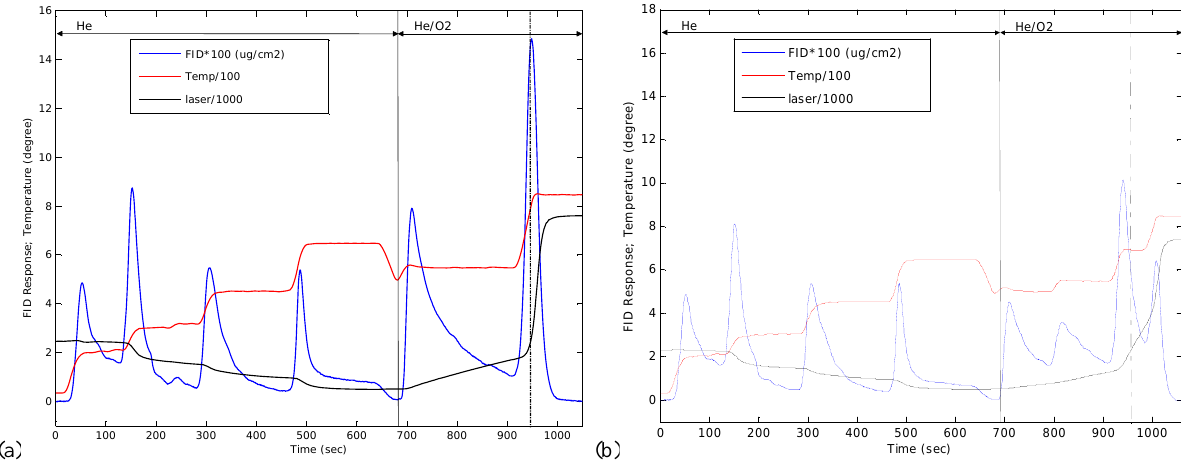
Fig. 4. Thermograms from the analysis of an aerosol sample with the EUSAAR 1 (a) and EUSAAR 2 (b) protocols. depends on sample load and composition, specifying a sin- gle thermal protocol for which both biases would